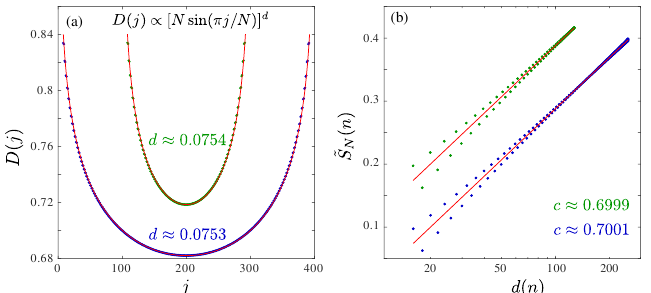
Figure 11: (a) Friedel oscillations at the tricritical Ising point induced by fixed bound- ary conditions with first and last sites occupied by bosons. (b) Scaling of the reduced entanglement entropy with the conformal distance d ( n ) . Green and blue dots are = 200 and N = 400 rungs respectively. Red lines DMRG data for ladders with N r r = 200 are are the results of the fit with CFT predictions. In (b) the results for N r shifted vertically by − 0.05 for clarity.